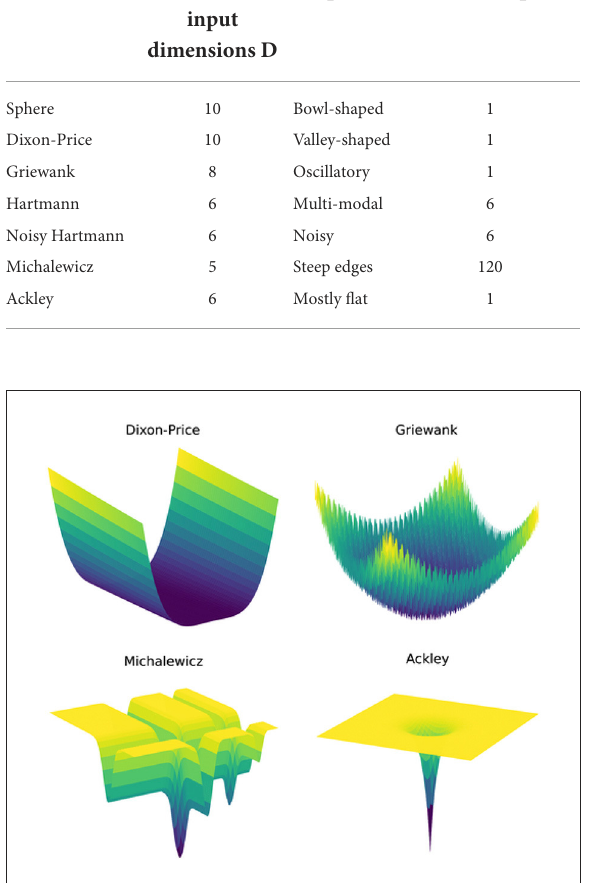
FIGURE1 Different challenges and levels of complexity of the simulations represented by the shapes of four test